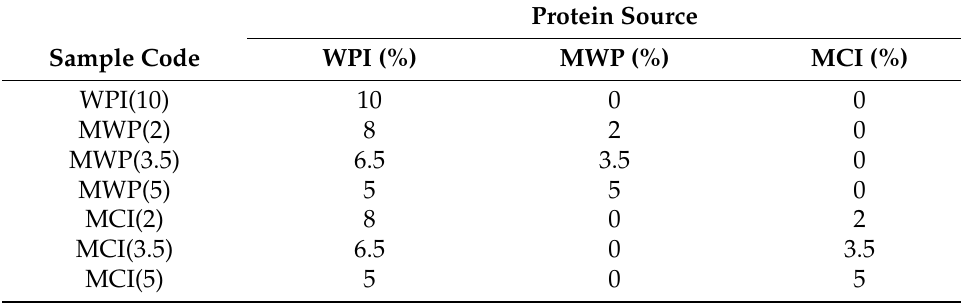
Table 1. Composition of emulsion gels with 10% protein and 10%